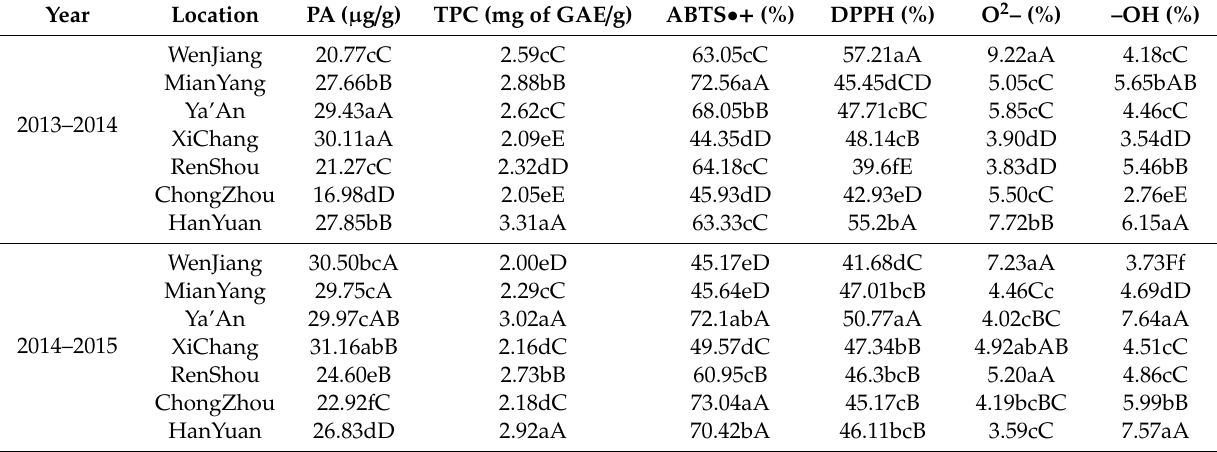
Table 3. Comparison of bioactive compounds contents and antioxidant capacities of 28 wheat cultivars at di ff erent sites.